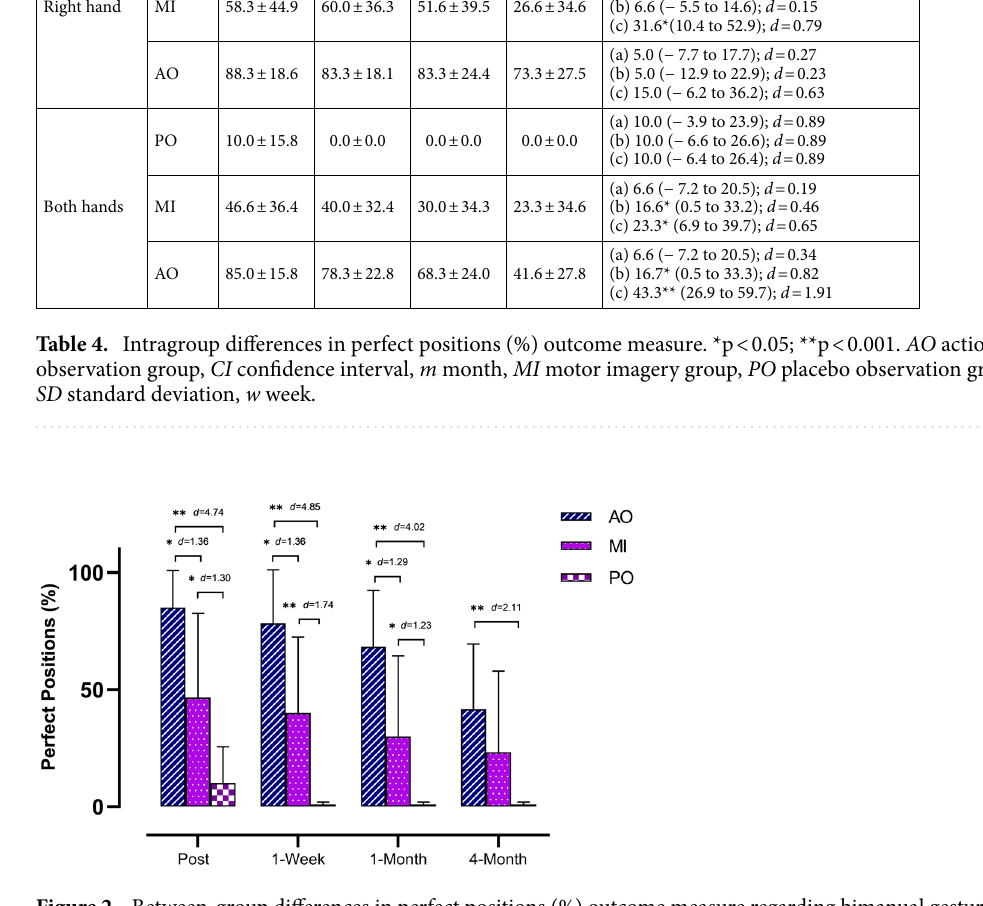
Figure 2. Between-group differences in perfect positions (%) outcome measure regarding bimanual gestures. *p < 0.05; **p < 0.001; AO action observation, MI motor imagery, PO placebo observation group, d d of